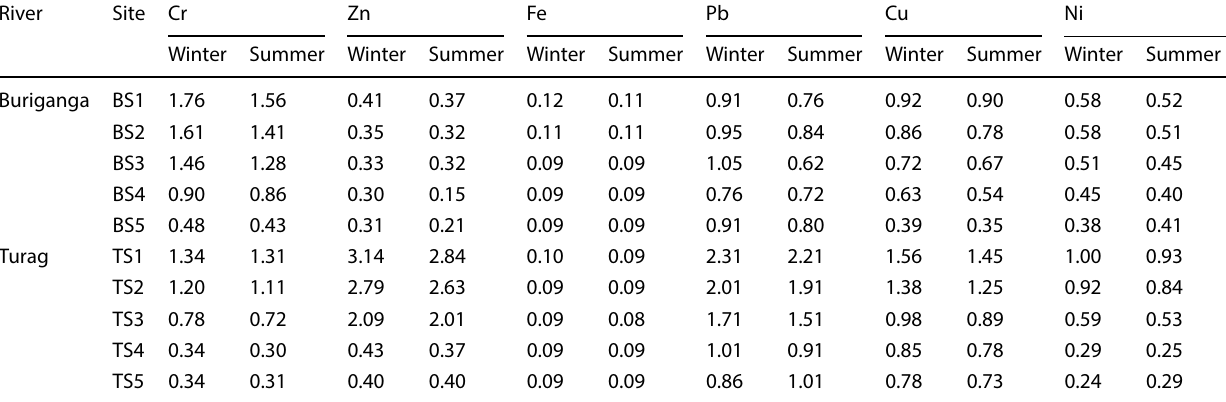
Table 6 Contamination factor (CF) of heavy metals in sediment of two studied Rivers